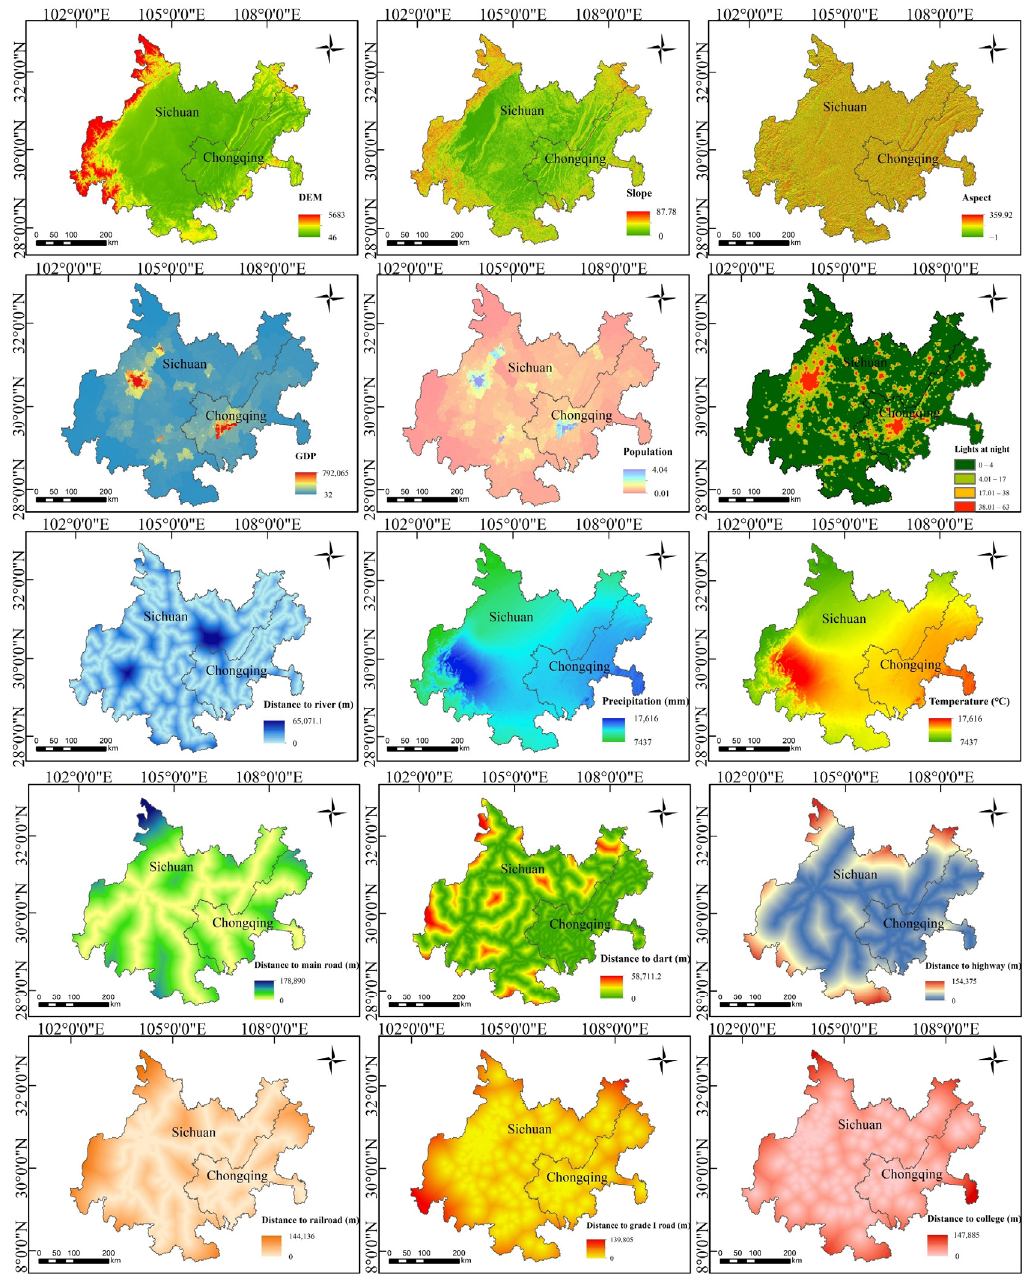
Figure 2. Main drivers behind land usage in the urban agglomeration of Chengdu and Chongqing.